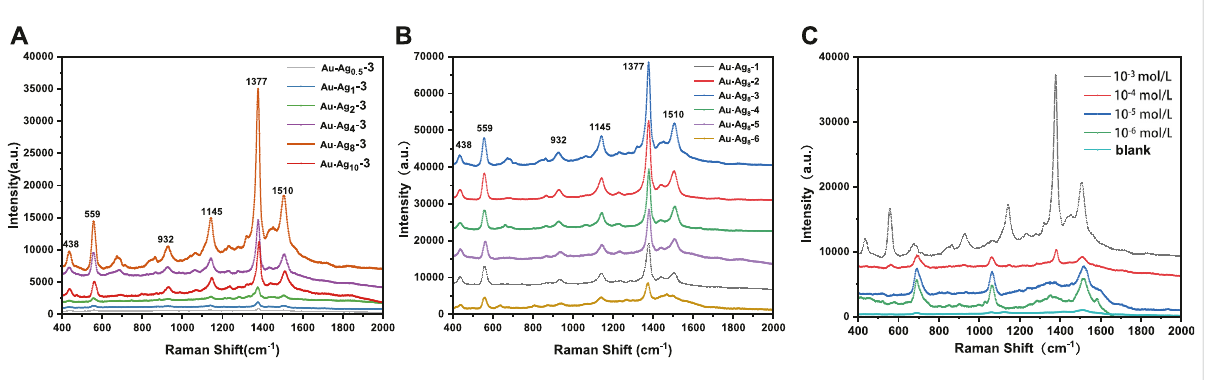
FIGURE 7 (A) The Raman spectra of thiram at 10 – 3 mol/L on the surface of Au-Ag m -3-FP, (B) the Raman spectra of thiram at 10 – 3 mol/L on the surface of